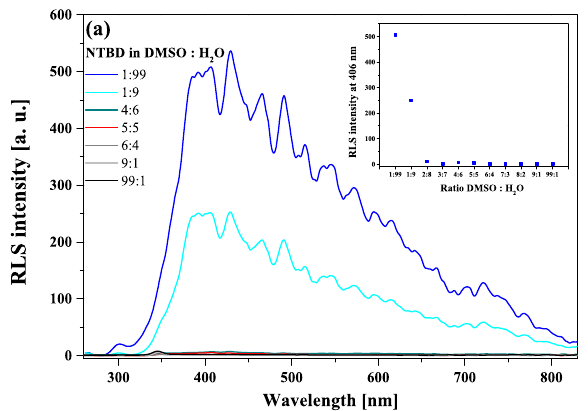
Figure 9. RLS spectra measured for NTBD in DMSO: H 2 O solutions with various – 1:99, 1:9, 4:6, 5:5, 6:4, 9:1 and 99:1 – volume ratio (panel a). The inset in ( a ) contains RLS spectra intensity at 406 nm versus DMSO: H 2 O solutions with various volume